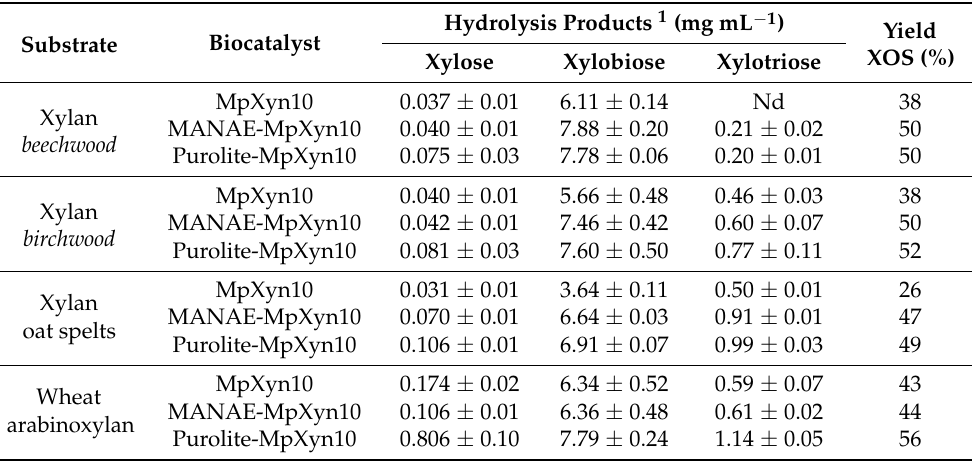
Figure 5. Profile of xylan hydrolysis from free and immobilized MpXyn10. ( A ) Reducing sugars released from beechwood xylan hydrolysis catalyzed with MpXyn10. ( B ) Thin Layer Chromatography (TLC) profile of hydrolysis of beechwood xylan, ( C ) wheat arabinoxylan, ( D ) birchwood and oat spelt xylans. The reducing sugars were quantified with the DNS method. Key: ( A ) free MpXyn10 ( • ), MANAE-MpXyn10 ( ■ ), and Purolite-MpXyn10 ( ▲ ); ( B , C ) lane 1: the beginning of the reaction; lanes 2–4: free MpXyn10; lane 5: MANAE-MpXyn10; lane 6: Purolite-MpXyn10; ( D ) lanes 1 and 5: the beginning of the hydrolysis of xylan birchwood and oat spelts, respectively; lanes 2 and 6: free MpXyn10; lanes 3 and 7: MANAE-MpXyn10; lanes 4 and 8: Purolite-MpXyn10. Controls were carried out to evaluate the spontaneous hydrolysis of the substrate under the same assay conditions. Table 2. Products obtained from the hydrolysis of the different xylans catalyzed by free and immobi- lized